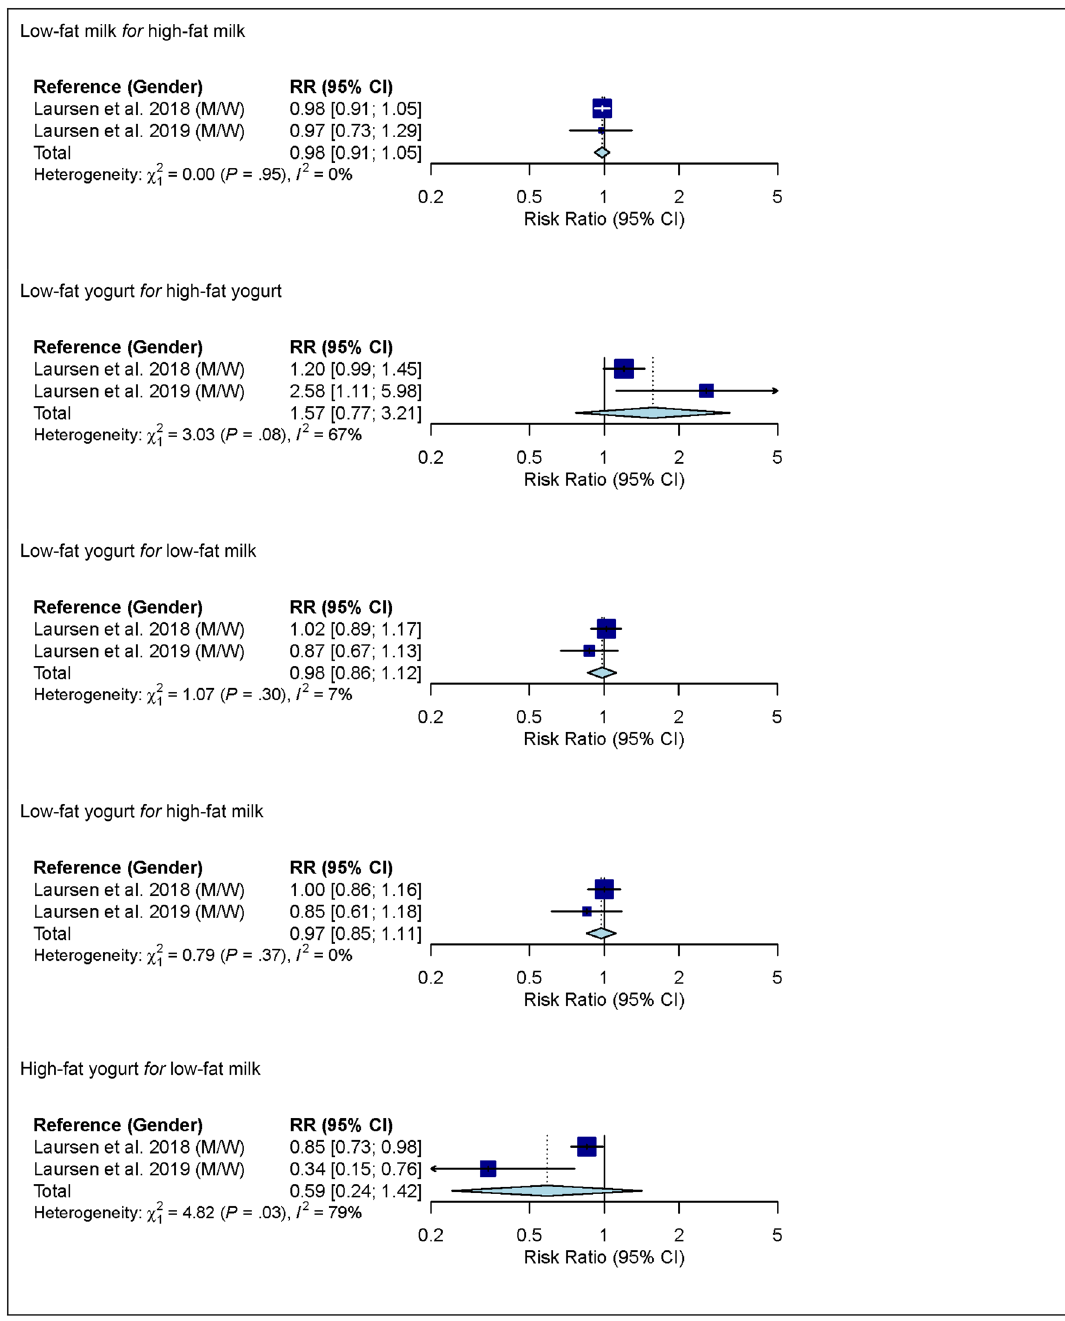
Figure 5. Linear dose–response meta-analysis. Summary RR of ischemic stroke for substitutions between dairy product subgroups (per 1 serving/day). For example in the mean of substitution of low-fat milk for high-fat milk; i.e. low-fat milk takes the place of high-fat milk). For milk and yogurt, the serving size was 200 g, for cheese 20 g, and for butter 6 g. Yogurt defined as yogurt/other soured milk products. CI confidence interval; M males; RR risk ratio; W